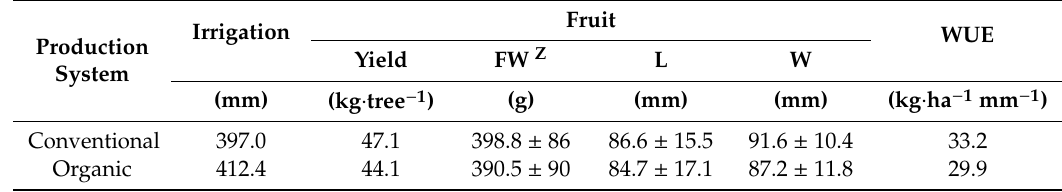
Table 2. Impact of irrigation (100% ET C ) on fruit yield and water-use e ffi ciency for the two production